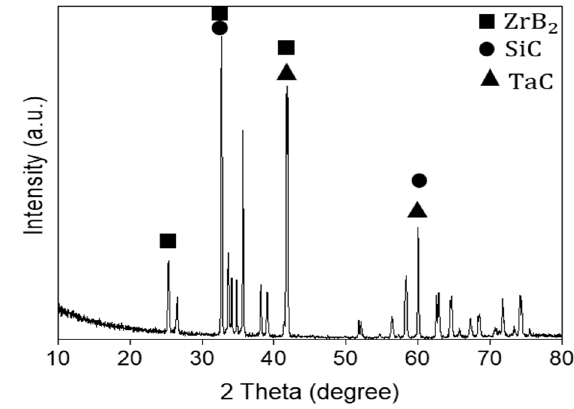
Figure 3. X-ray di ff raction (XRD) pattern of ZrB 2 –SiC–TaC. Figure 3. X-ray diffraction (XRD) pattern of ZrB 2 –SiC–TaC. Figure 3. X-ray diffraction (XRD) pattern of ZrB 2 –SiC–TaC.